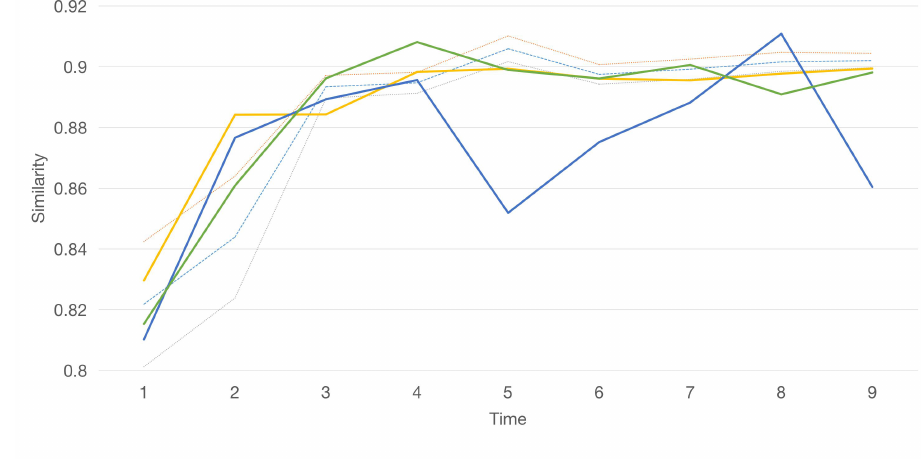
Figure 15. Detection of an anomaly with 5% occurrence probability. Perturbed event order shows obvious deviation compared to other anomalies. However, mixed anomaly was detected a bit slower compared to other anomalies.